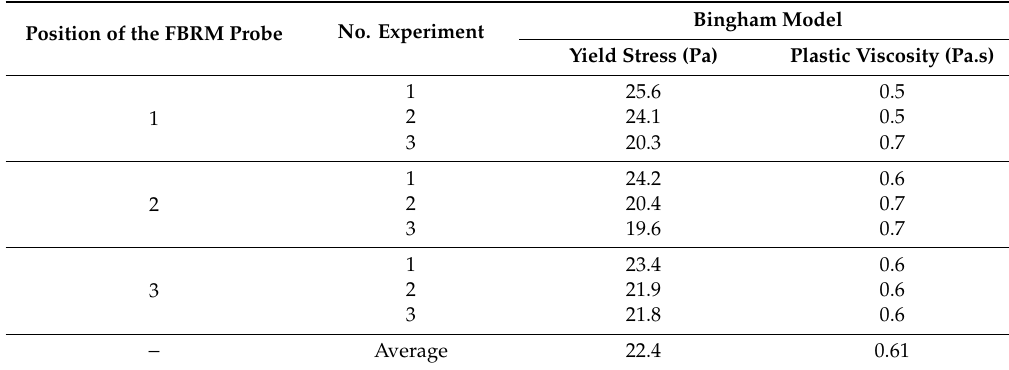
Table 2. Bingham rheological parameters for cement